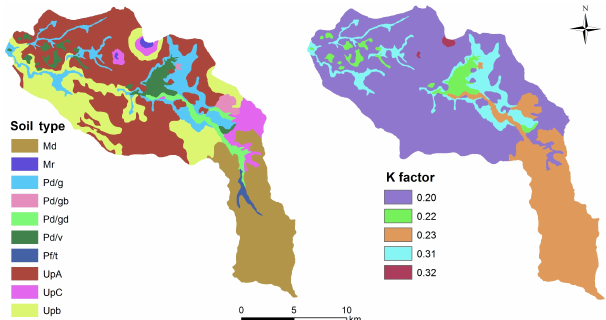
Figure 4. Calculated mean K values map (right) based on data from the soil type map (left) of the study